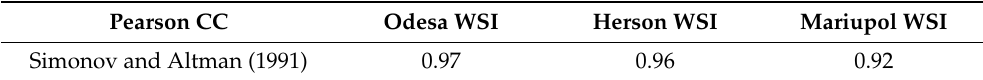
Figure 11. WSI of the historical data for the northern coast of the Black Sea and Odesa, Herson and Mariupol from the GSOD database; the lowest panel shows the new WSI time series and the calculated linear trend with dashed line (black for the period 1926–2021 and red for the last 30 years, 1991–2021). Table 2. Linear correlation coefficient between the curves in Figure 11 for the overlapping period 1950–1985.